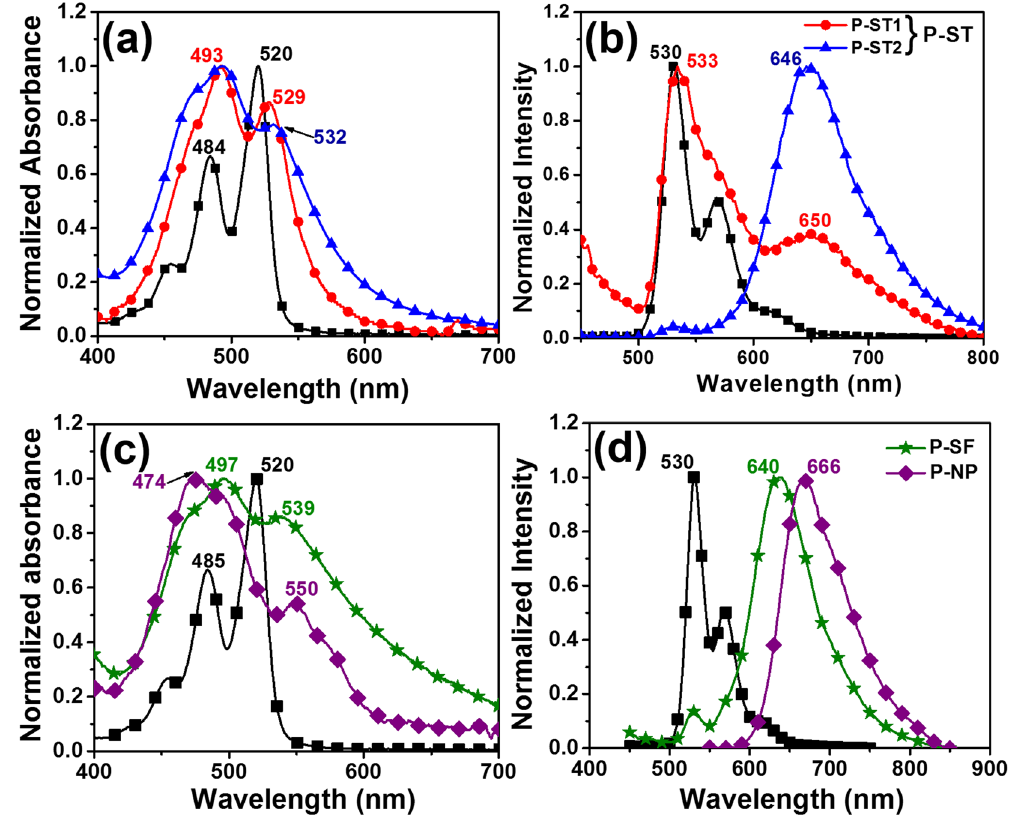
Figure 3. Absorbance ( a,c ) and emission spectra ( b,d ) of ( ■ ) PDI silane monomer, P-ST1 ( ), P-ST2 ( ), P-SF ( ) dispersed in THF and P-NP ( ) dispersed in water. Excitation wavelength was 350